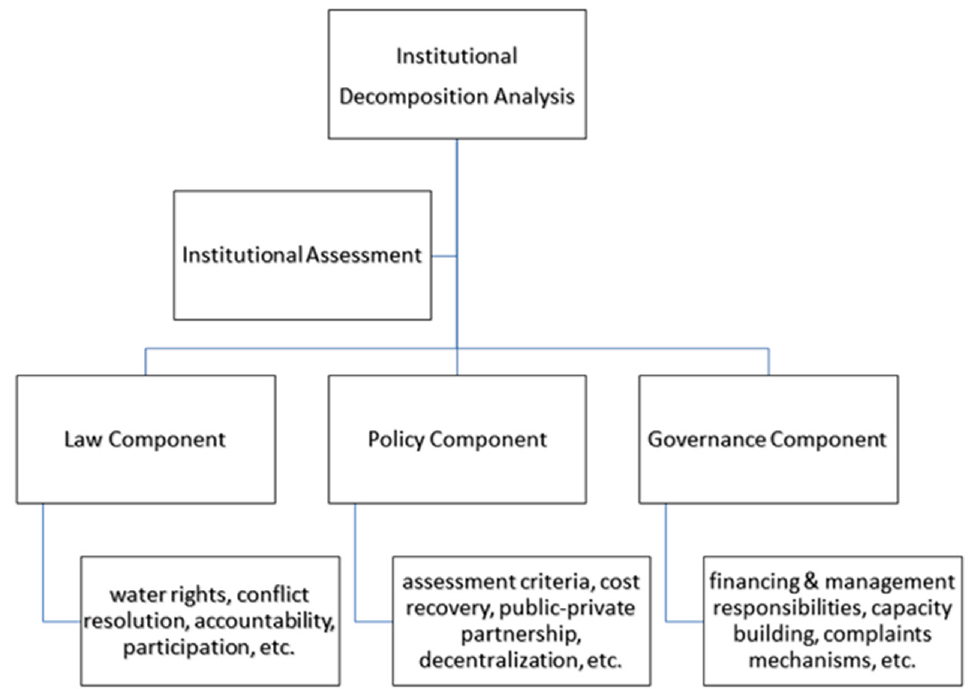
Figure 1. Framework for the institutional